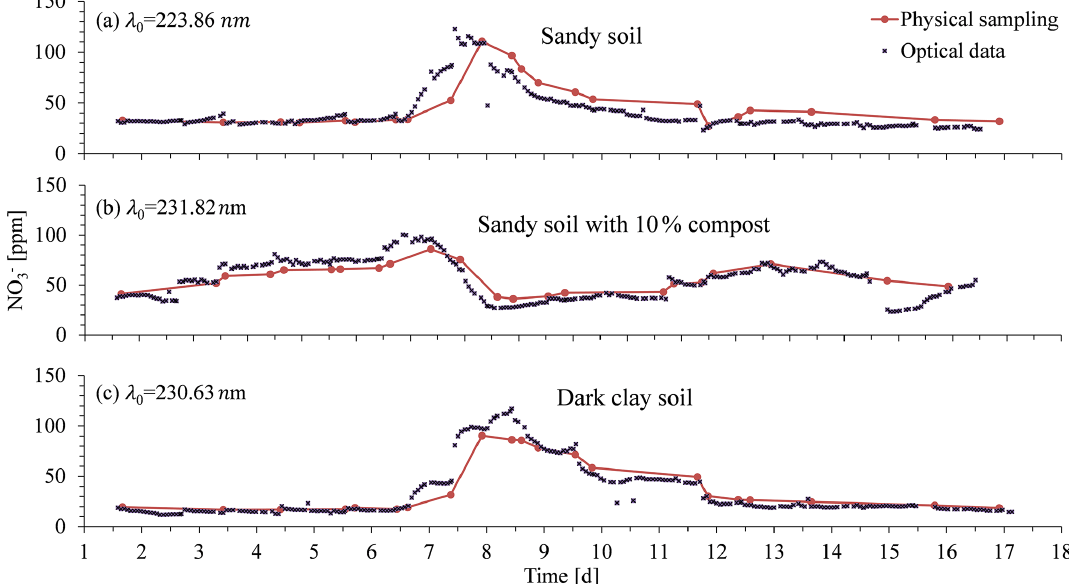
Figure 11. Nitrate breakthrough curves for (a) sandy loam, (b) sandy loam with 10% compost, and (c) dark clay